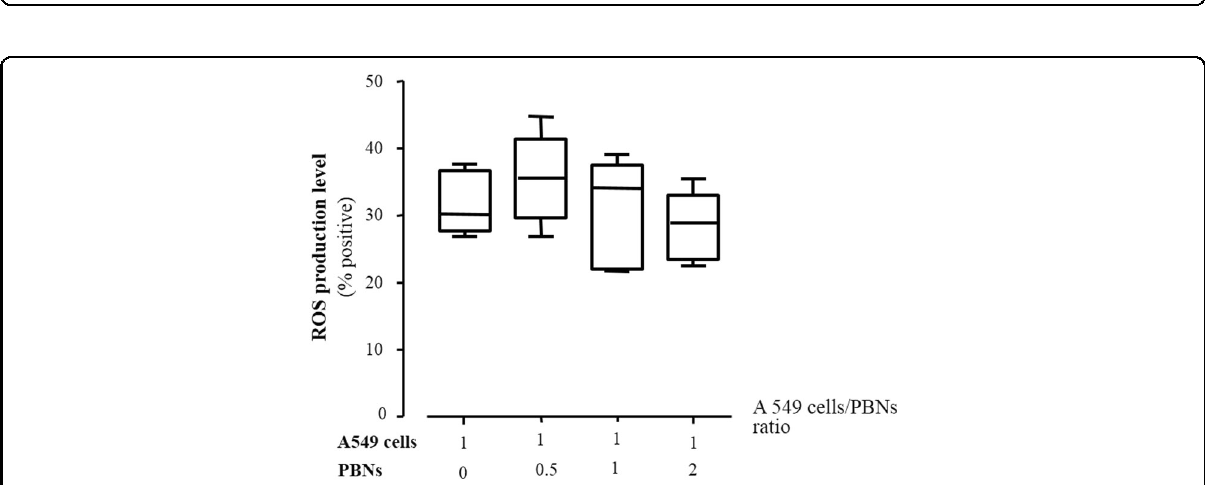
Fig. 6 Intracellular reactive oxygen species production by A549 cells co-cultured with neutrophils. A549 cells (2 × 10 5 cells per mL) and neutrophils were incubated with 50 μ M H2DCFDA for 30 min at 37 °C. The ratios represent the number of A549 cells relative to that of PBNs. Data are presented as the mean ± SEM of duplicate results from at least three independent experiments. PBNs peripheral blood